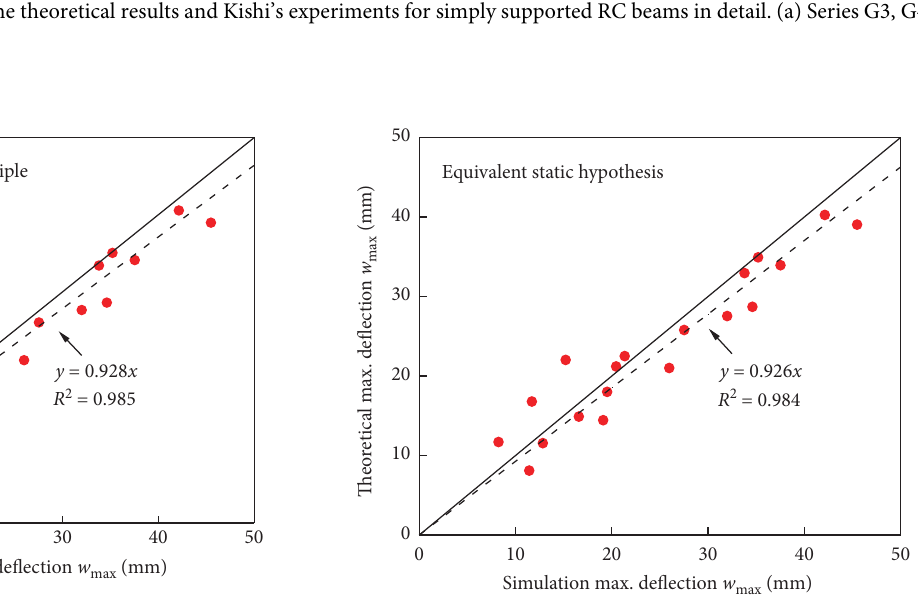
Figure 15: Comparison between the simulation and theoretical results calculated by the equivalent static hypothesis for fully clamped RC